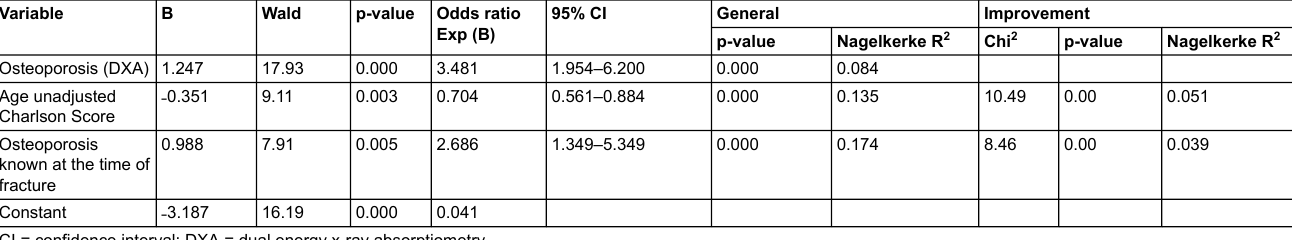
Table 3: Multivariate stepwise logistic regression analysis on the use of specific osteoporotic therapy (n = 255).